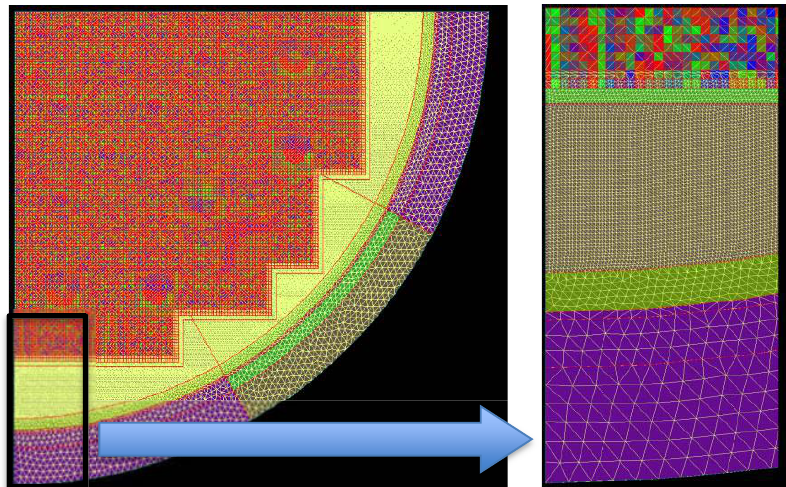
Figure 3. MINARET full-core radial spatial